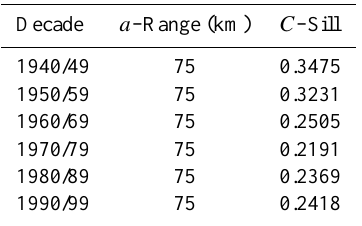
Table 2. Parameters of the exponential variogram models for the 12-month SPI, by